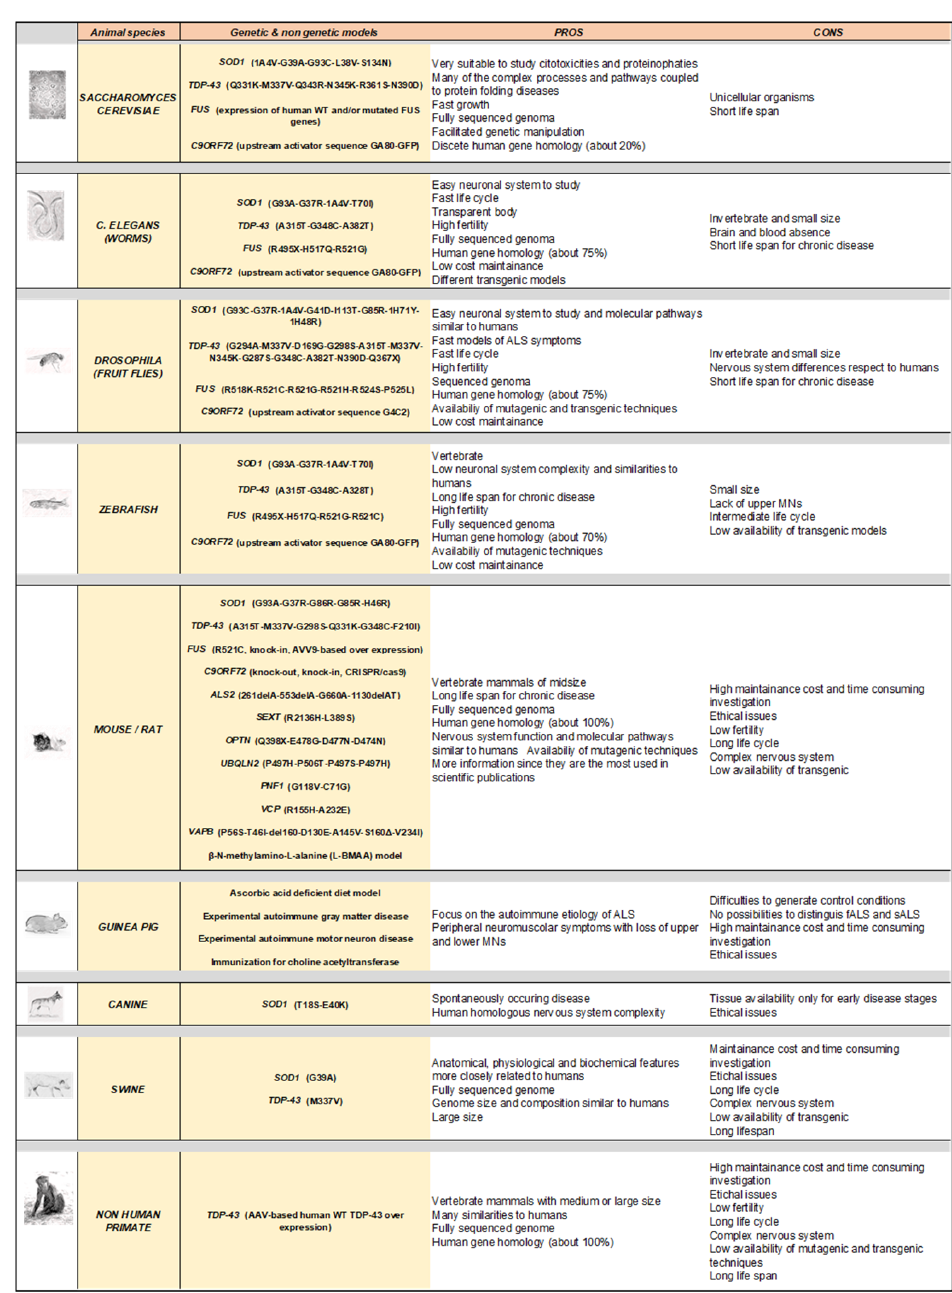
Figure 1. Pros and cons of available ALS animal models.